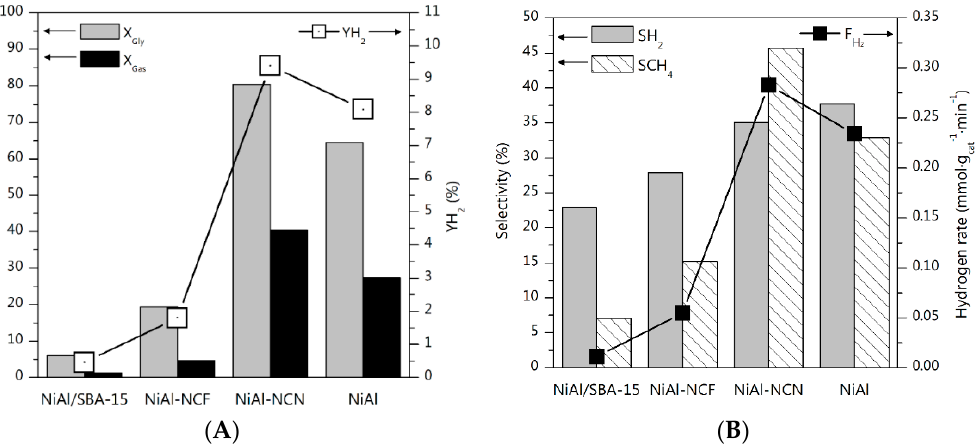
Figure 6. ( A ) Glycerol conversion, conversion to gas and hydrogen yield; ( B ) Selectivity to H 2 and CH 4 , and H 2 production rate. Reaction conditions: 235 °C/35 bar, WHSV = 24.5 h − 1 . Reaction time: 3 h TOS.